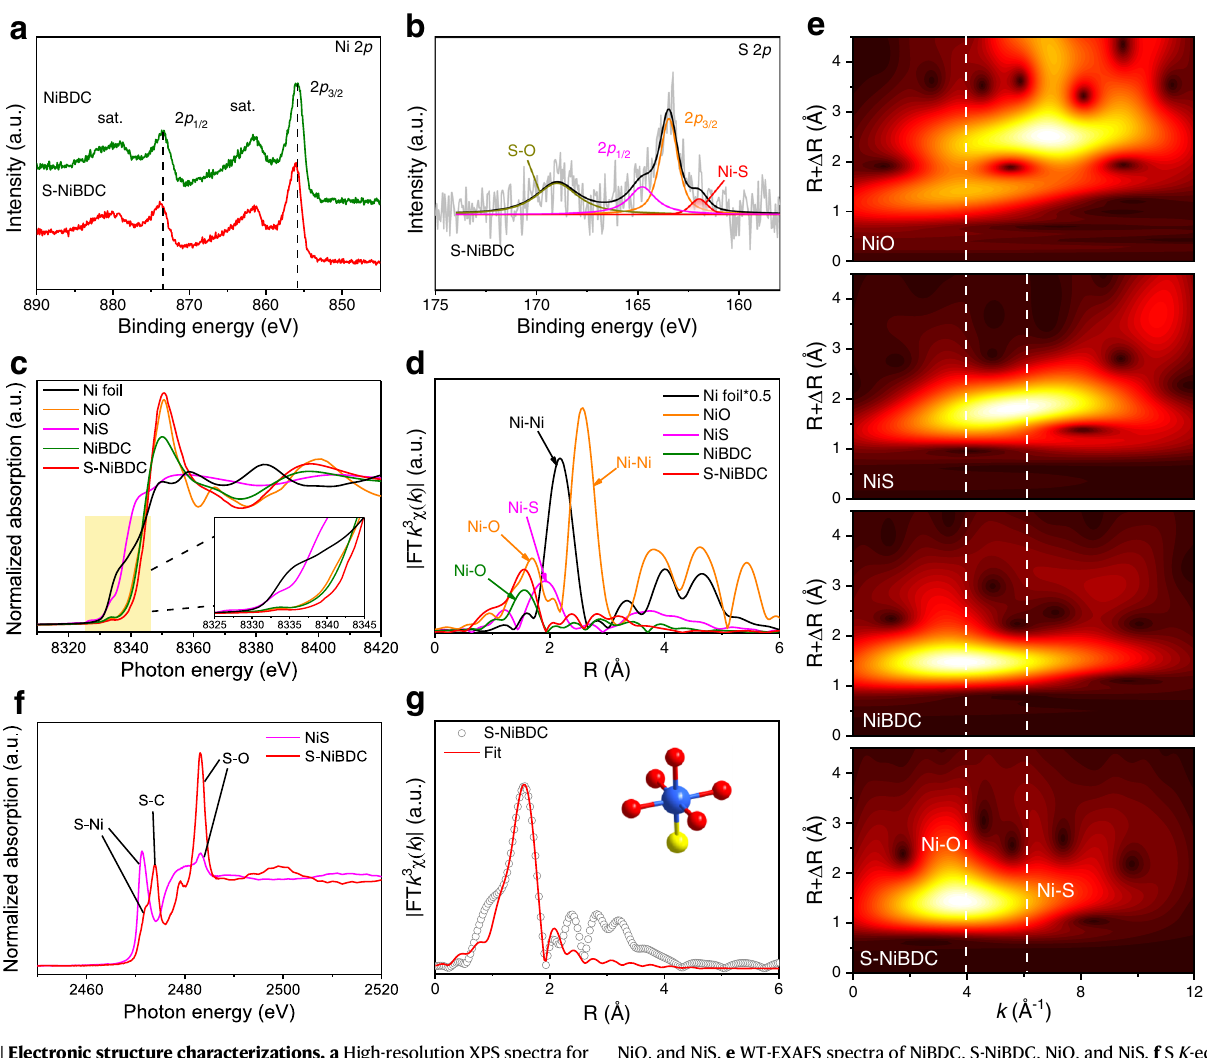
NiO, and NiS. e WT-EXAFS spectra of NiBDC, S-NiBDC, NiO, and NiS. f S K -edge XANES spectra of NiS and S-NiBDC. g Fourier transform-EXAFS fi tting results of